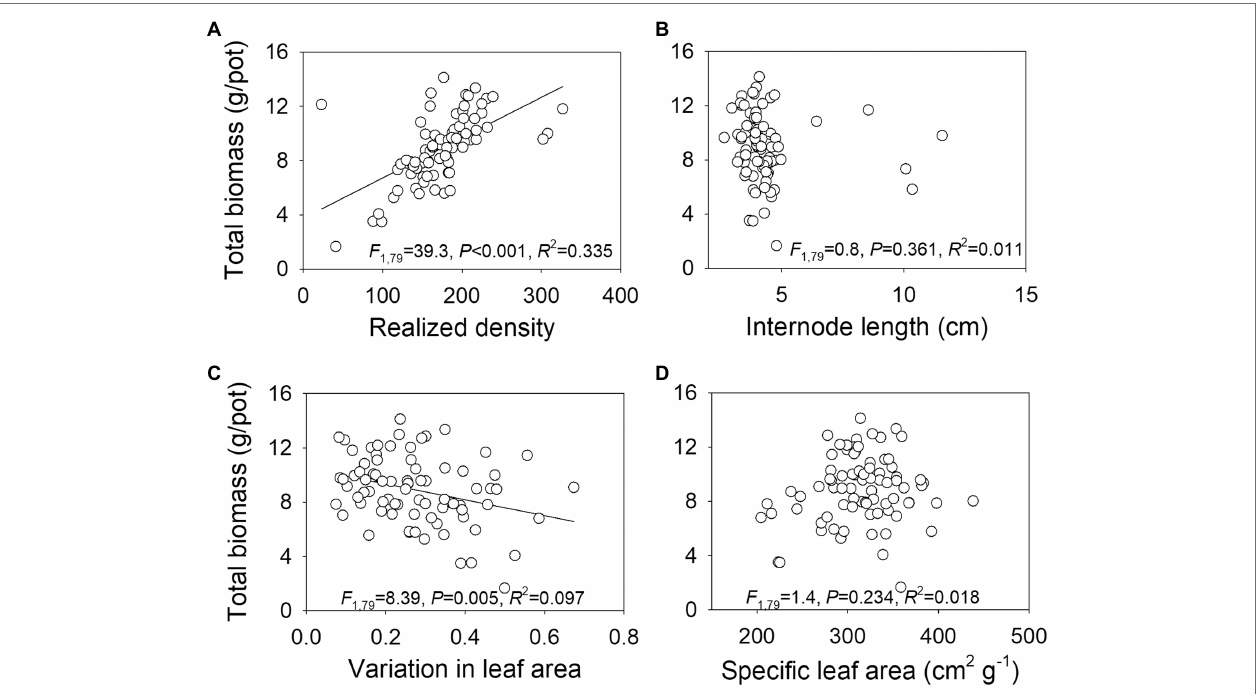
FIGURE 5 | Relationship between total biomass and realized density (i.e., number of ramets) at harvest (A) , internode length (B) , variation in leaf area (C) , and specific leaf area (D) in Hydrocotyle vulgaris population. Each dot represents a data point for a population. F -, R 2 -, and p -values obtained from linear regressions are also